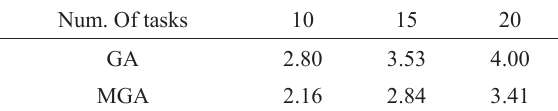
(b) Comparisons with m =15 varying n Num. Of